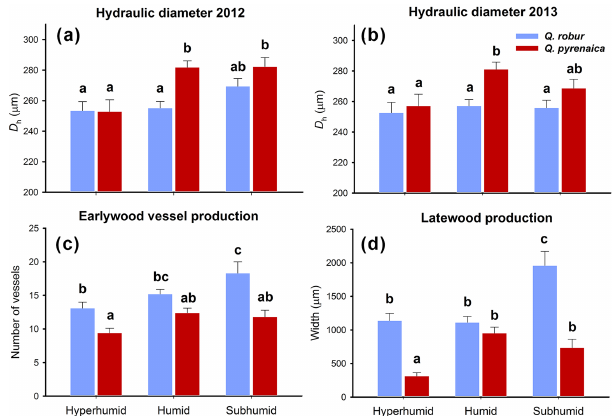
Figure 5. Mean values and SE of (a) stem diameter, (b) budburst date, (c) date of leaf shedding, and (d) foliage density in 2013 for Quercus robur ( N = 120) and Q. pyrenaica ( N = 120). Lower-case letters indicate statistically significant differences along the gradient according to multiple pairwise